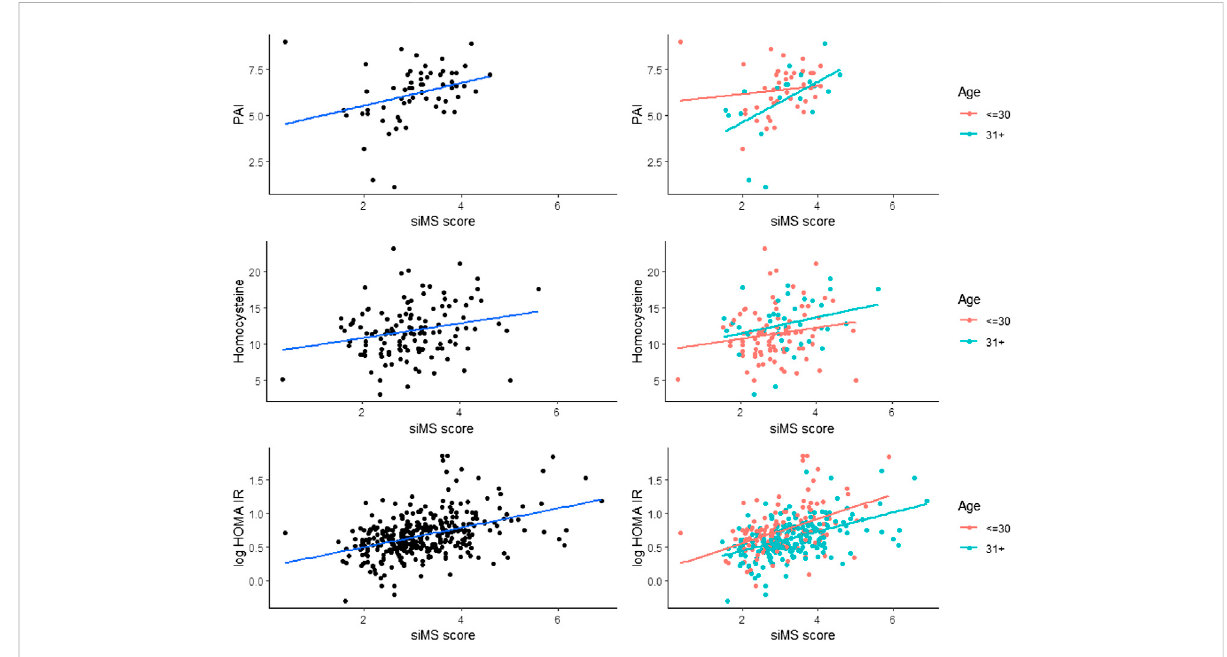
FIGURE 1 siMS score correlations with associated MS parameters: PAI-1, homocysteine and log HOMA IR.